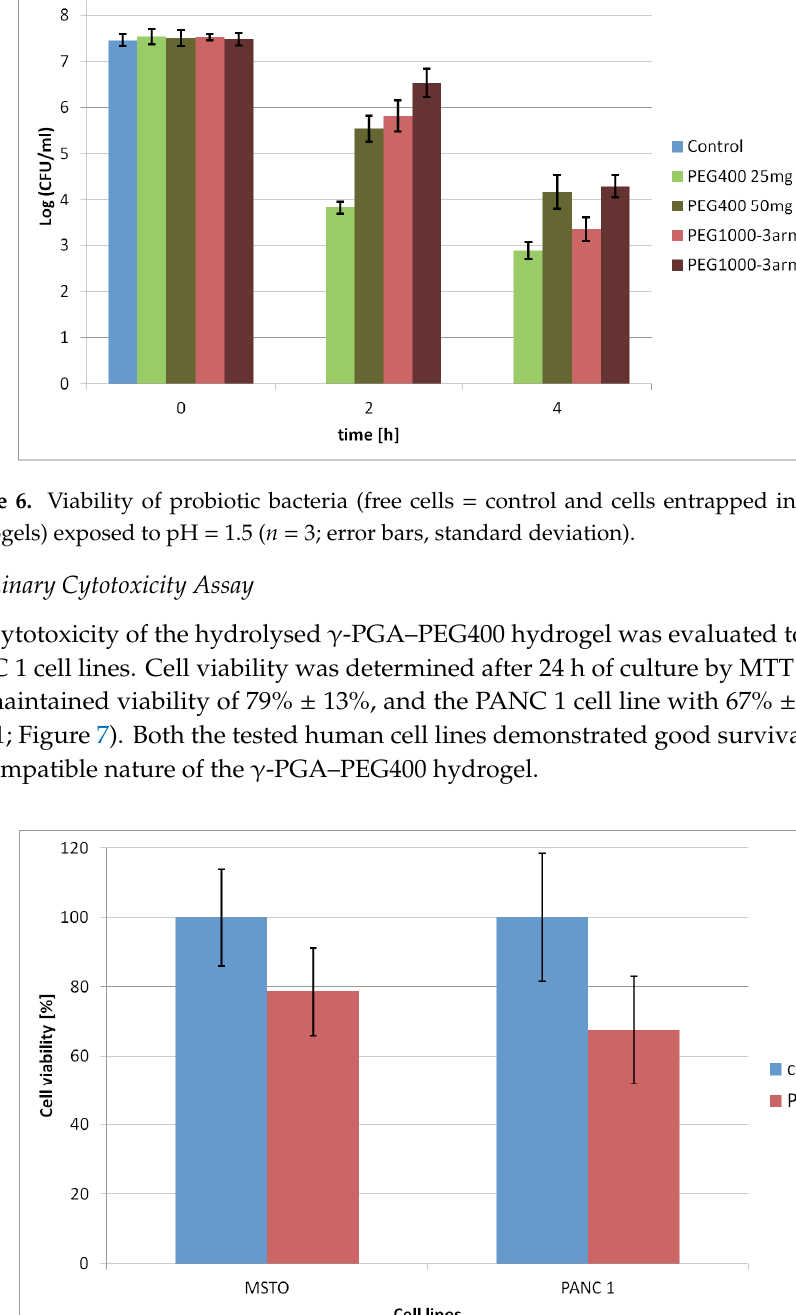
Figure 6. Viability of probiotic bacteria (free cells = control and cells entrapped in γ -PGA-based hydrogels) exposed to pH = 1.5 ( n = 3; error bars, standard deviation).